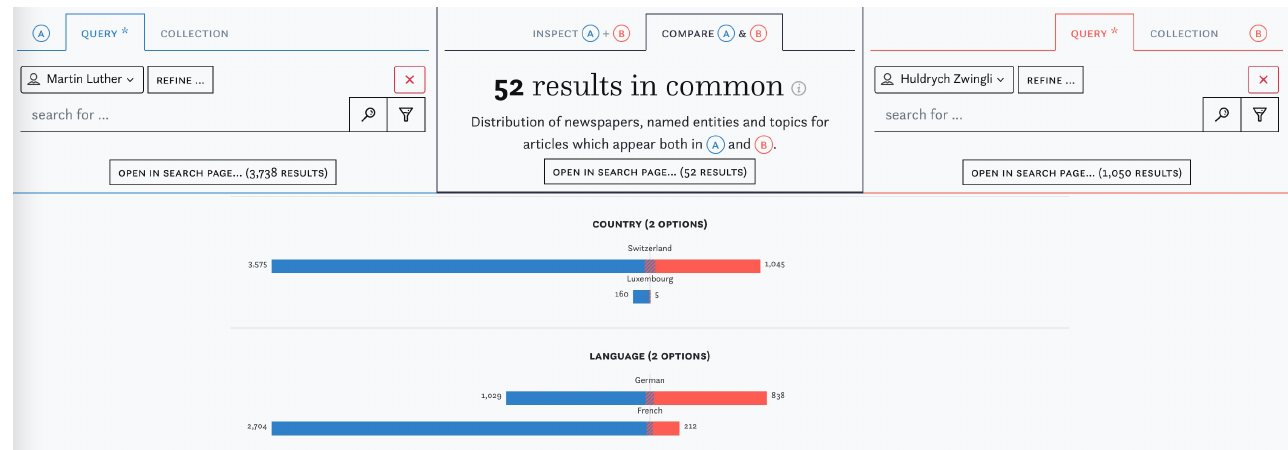
Figure 3. Contextual information about a linked named entity.